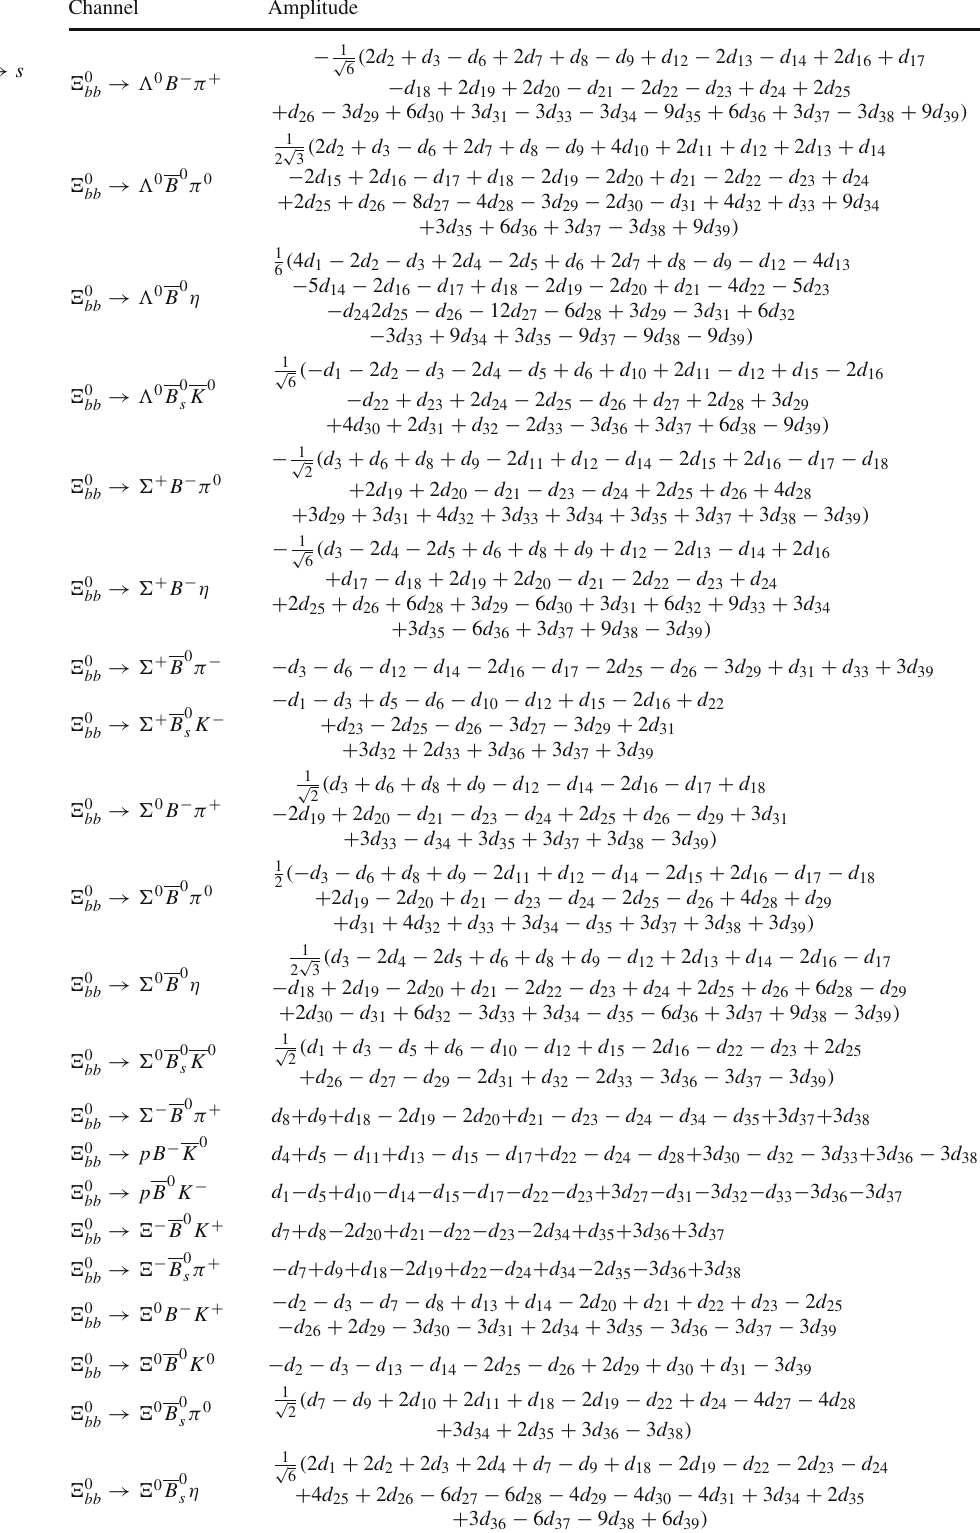
Table 30 Doubly bottom baryon decays into a bottom meson, a light baryon(8) induced by the charmless b → s transition and a light